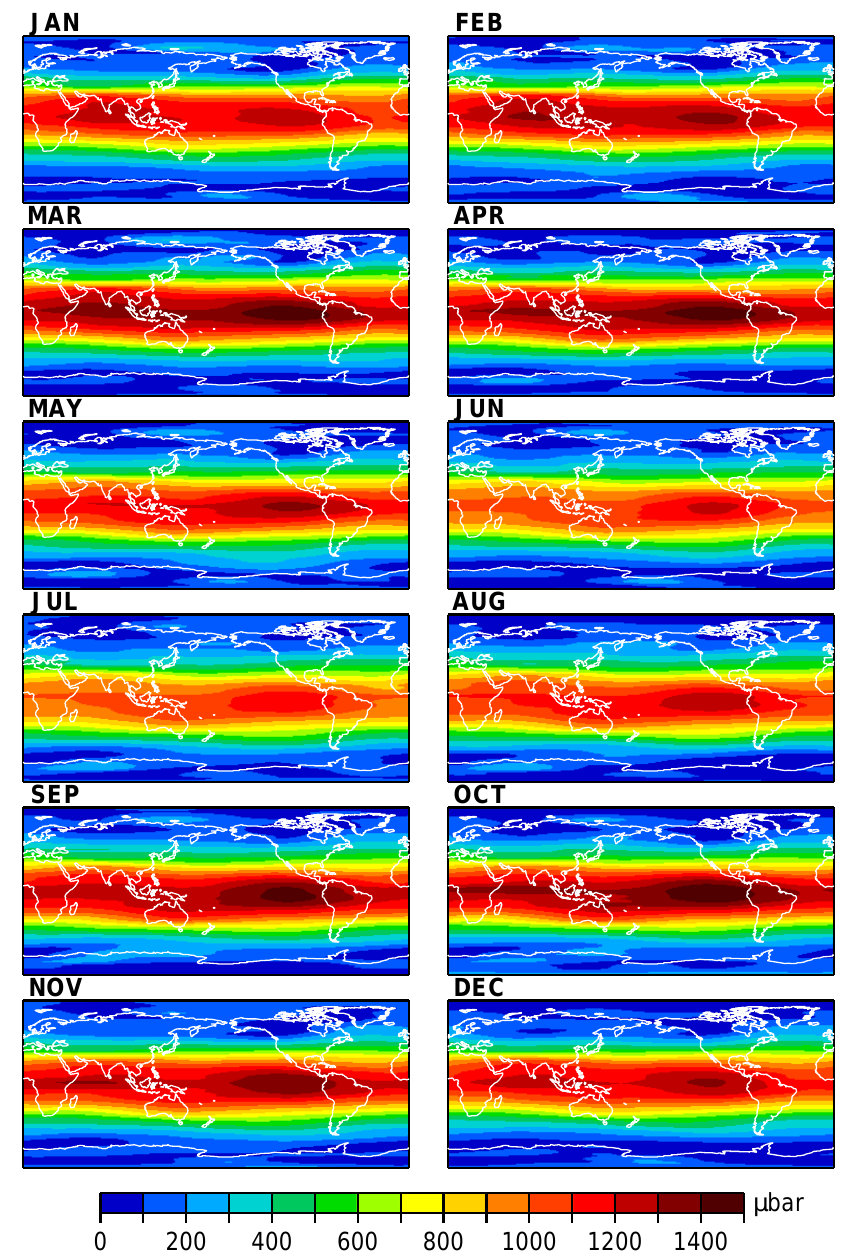
Fig. 9. Monthly mean amplitude of the S 2 (p) tide as deduced from ECMWF surface pressures.